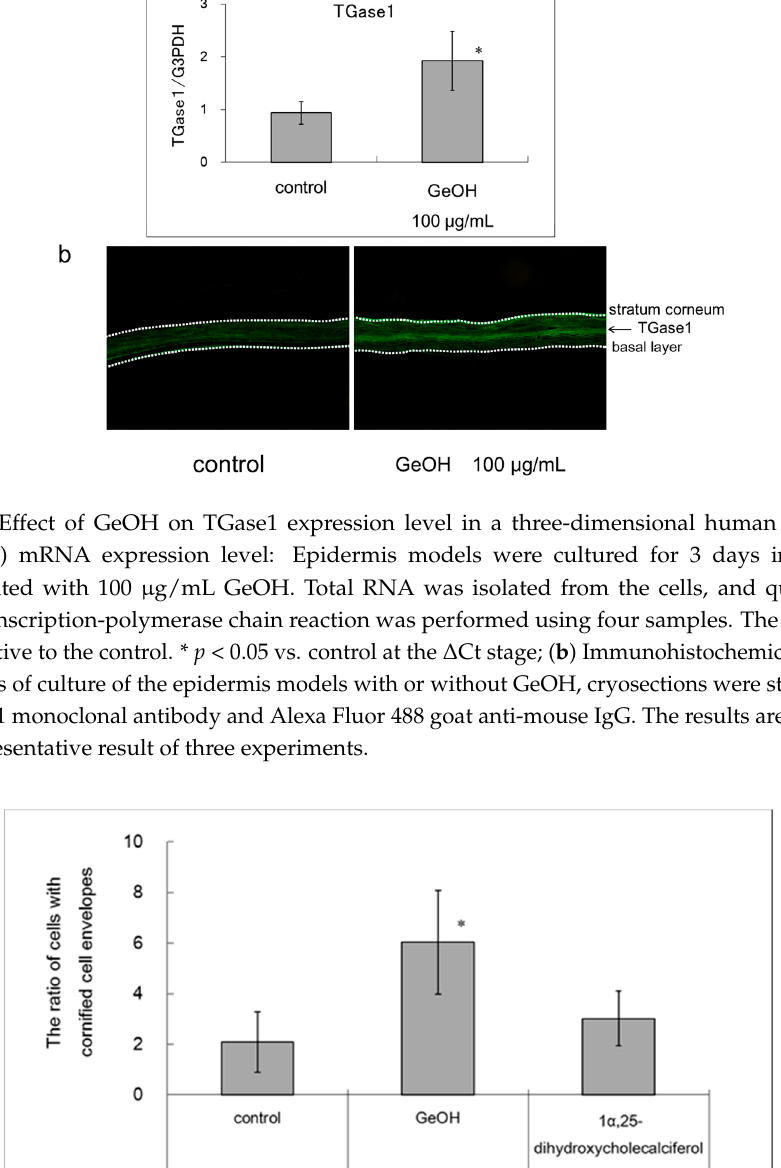
Figure 5. Effect of GeOH on cornified cell envelope (CE) formation in cultured epidermal keratinocytes. HaCaT cells were cultured for 4 days in medium supplemented with 100 µ g/mL GeOH or 0.5 µ g/mL 1 α ,25-dihydroxycholecalciferol. CE formation was evaluated before and after the addition of a protein solubilizer to calculate the ratios of CEs to the total cell counts. The results are presented as the mean ± S.D. of three experiments. * p < 0.05 vs. control.